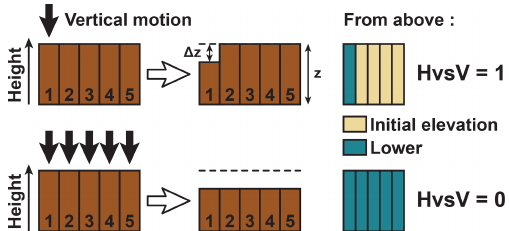
Figure 4. Schematic representation of the HvsV index used to quan- tify the observed and simulated thermokarst patterns. The index ranges from 1, when the plateau undergoes pure lateral edge retreat (subsidence restricted to the areas at contact with the mire), to 0, when it experiences uniform